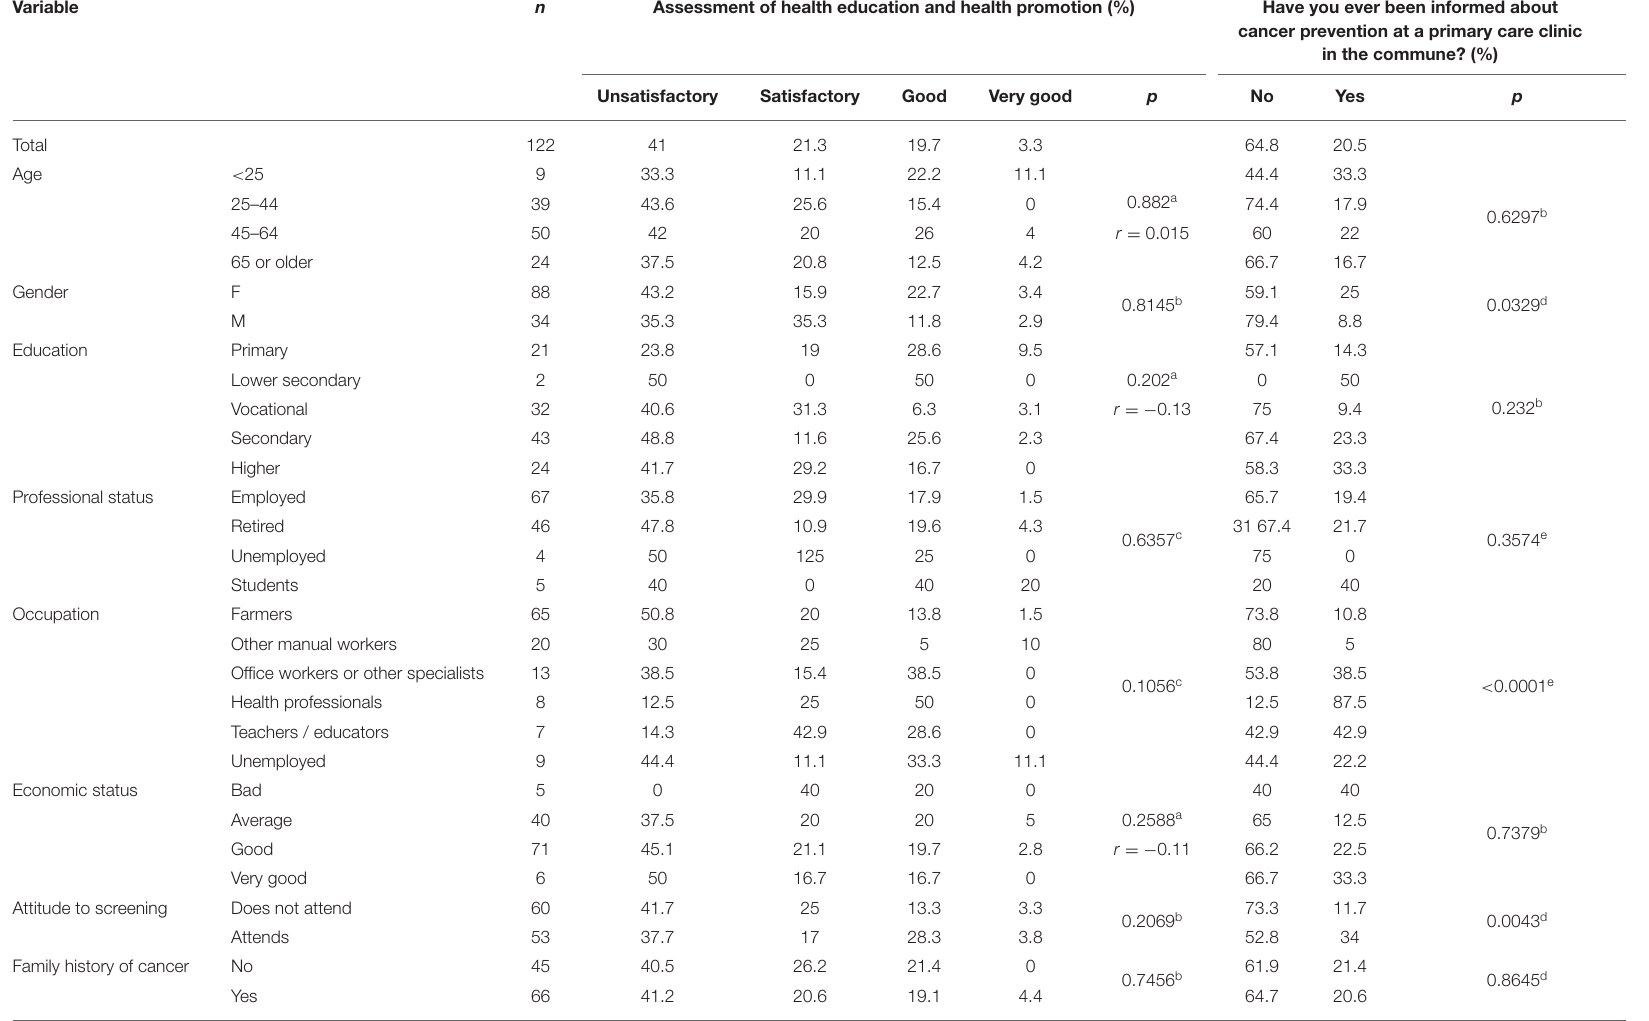
TABLE 7 | The assessment of health education and health promotion activities ( n = 122).